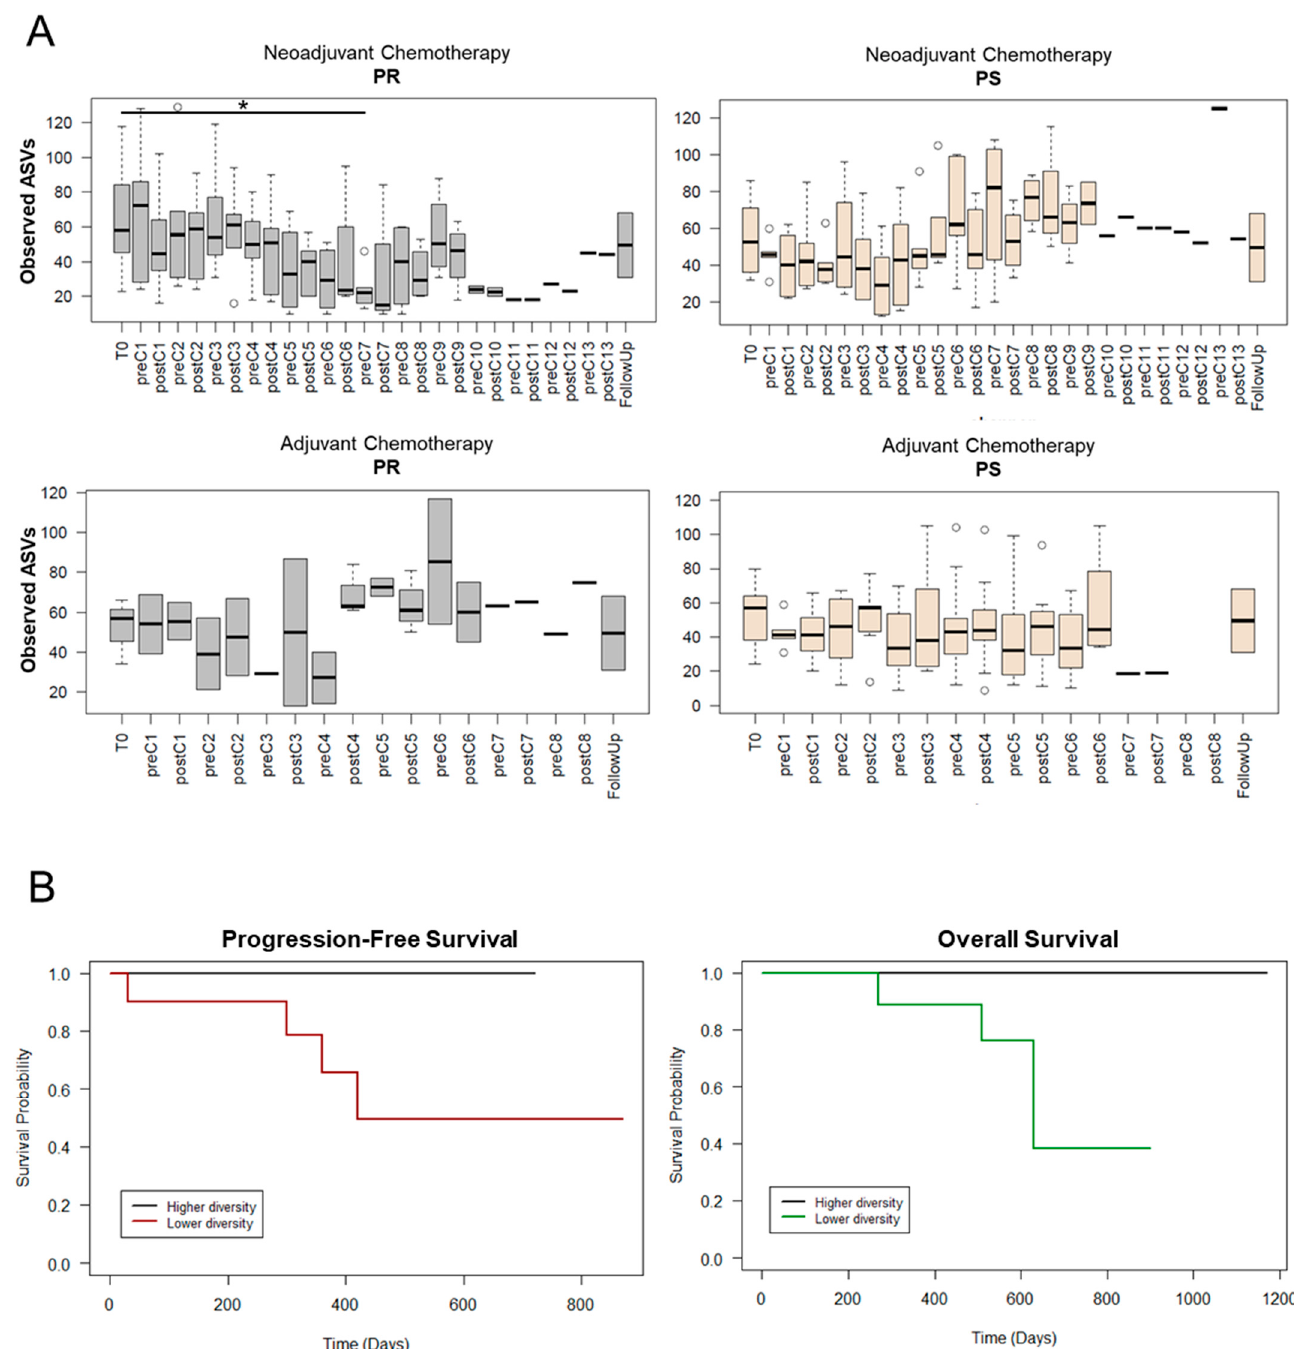
Figure 3. Dynamics of alpha diversity in EOC patients during chemotherapy based on therapeutic response and association with survival. ( A ) Boxplots showing the distribution of the number of observed ASVs during neoadjuvant (top) or adjuvant (bottom) chemotherapy. Patients were stratified by response to therapy: PR, platinum-resistant (left) vs. PS, platinum-sensitive (right). C, chemotherapy cycle. Wilcoxon test, * for p ≤ 0.05. ( B ) Kaplan–Meier curves for progression-free survival (left) and overall survival (right) in the whole cohort. EOC patients were stratified by higher or lower number of observed ASVs (relative to median) at the preC7 (for neoadjuvant therapy) or the preC4 (for adjuvant therapy) time-points. Log-rank test, p ≤ 0.1.